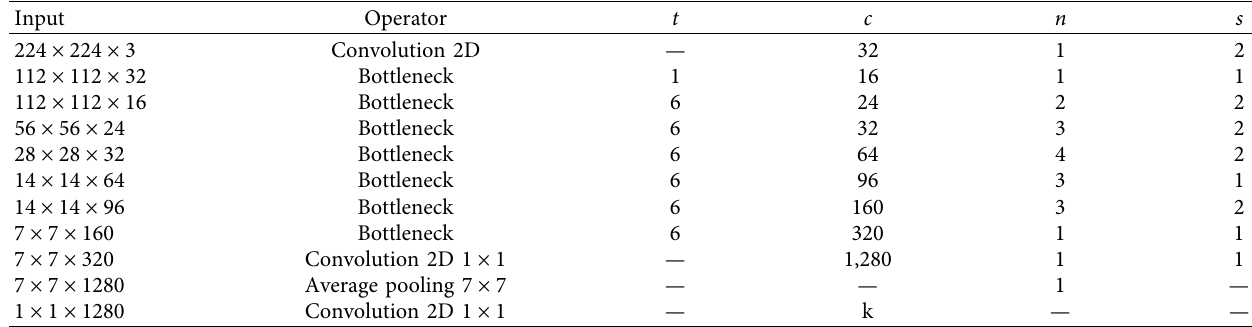
Table 3: MobileNetV2